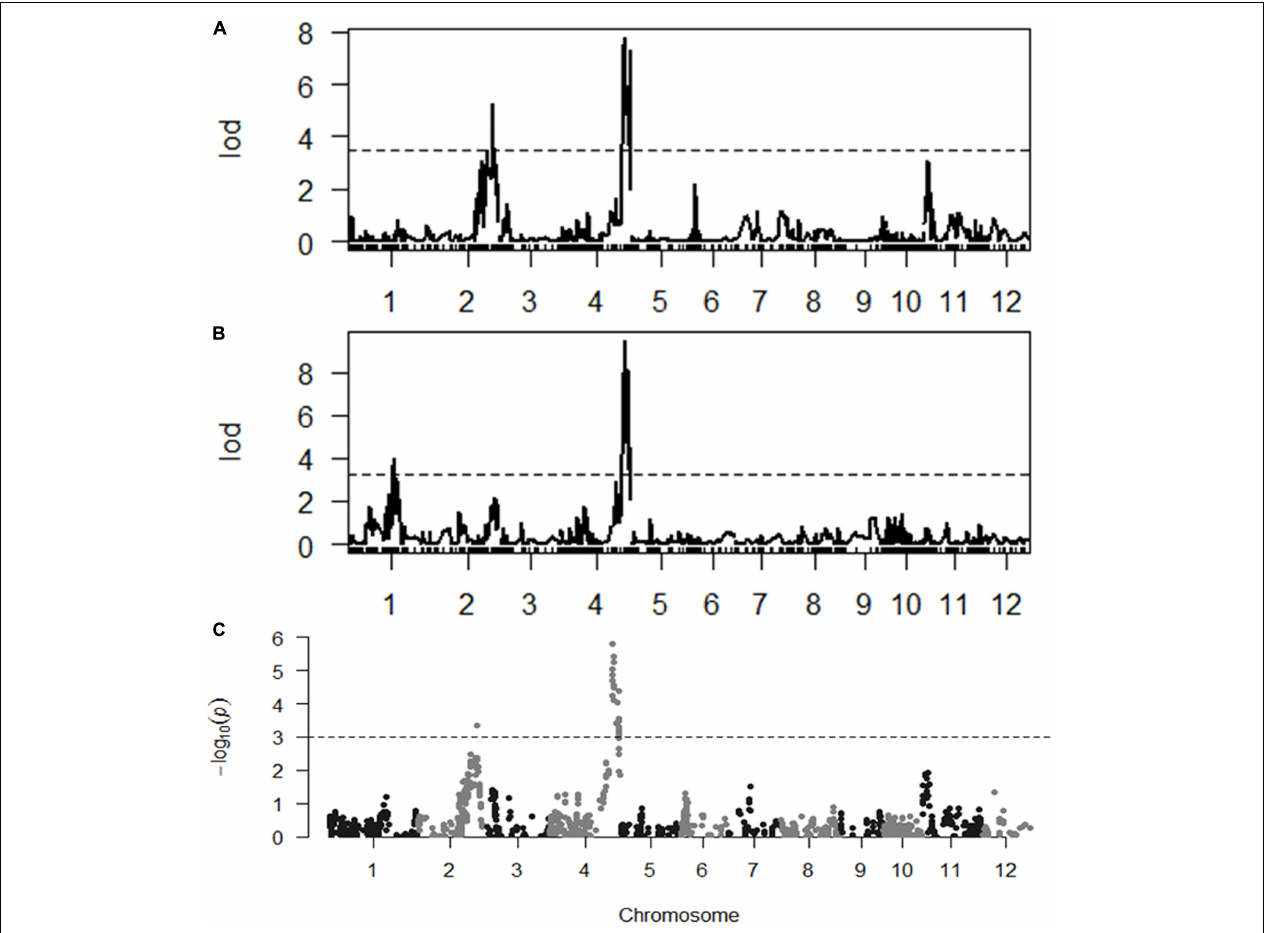
FIGURE 2 | (A,B) The LOD curve for a genome scan of Standard Evaluation System (SES) and chlorophyll content. The horizontal dashed line represents the threshold computed by 1000 permutations. (C) The p -value of segregation distortion test for whole genome SNP markers in selected population. The horizontal dashed line indicated the p -value at the threshold of q -value being